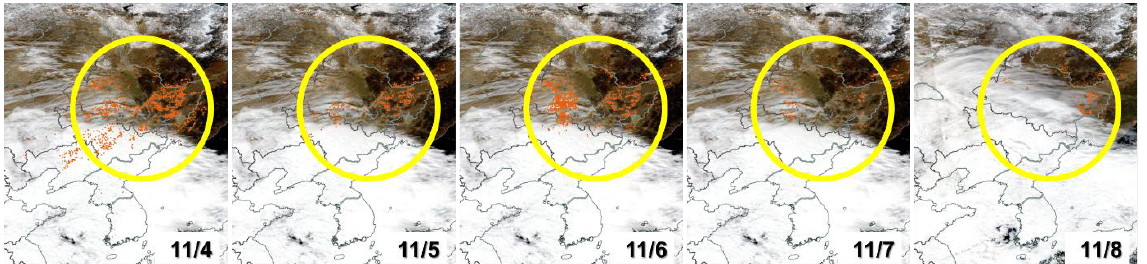
Figure 6. MODIS fire and thermal anomaly data from 4–8 November 2015.